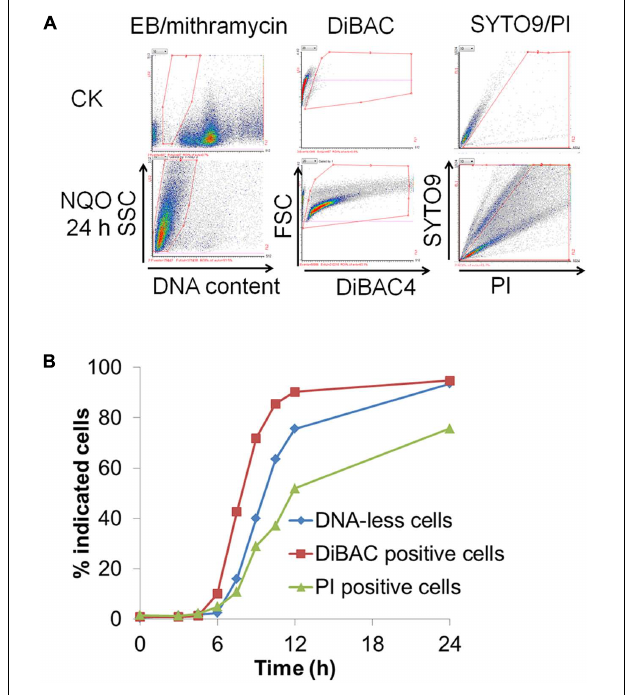
FIGURE 4 | Membrane depolarization occurs prior to chromosome degradation and loss of membrane integrity during the lethal NQO treatment. (A) Untreated and NQO-treated (24 h) cells were stained with DiBAC4, EB/mithramycinA and SYTO9/PI, respectively. The cells for EB/mithramycinA staining were prefixed by 70% ethanol for overnight. Then, the samples were analyzed by flow cytometry and the results were shown in FL2 (DNA content, horizontal axis)-SSC (vertical axis), FL1 (DiBAC, horizontal axis)-FSC (forward scattered light, vertical axis) and FL2 (PI, horizontal axis)-FL1 (SYTO9, vertical axis) cytograms, respectively. In the experiments, DiBAC-stained cells and SYTO9-stained cells emit green fluorescence (FL1), while PI-stained cells emit red fluorescence (FL2). Both axes are shown in liner scale. The entangled area indicates DNA-less cells (left panels), DiBAC-positive cells (middle panels) and PI-positive cells (right panels). (B) Quantification of the percentage of DNA-less cells, DiBAC-positive cells and PI-positive cells during NQO treatment. The data are the representatives of three independent